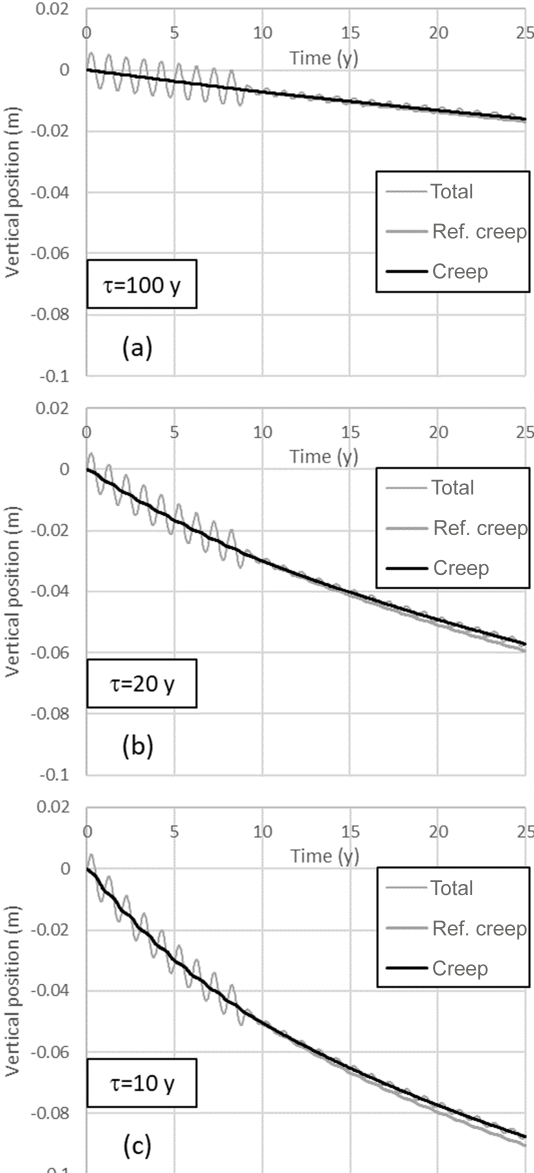
Figure 5. Calculated subsidence for scenario “raising”. The creep of the reference runs is depicted as “ref.